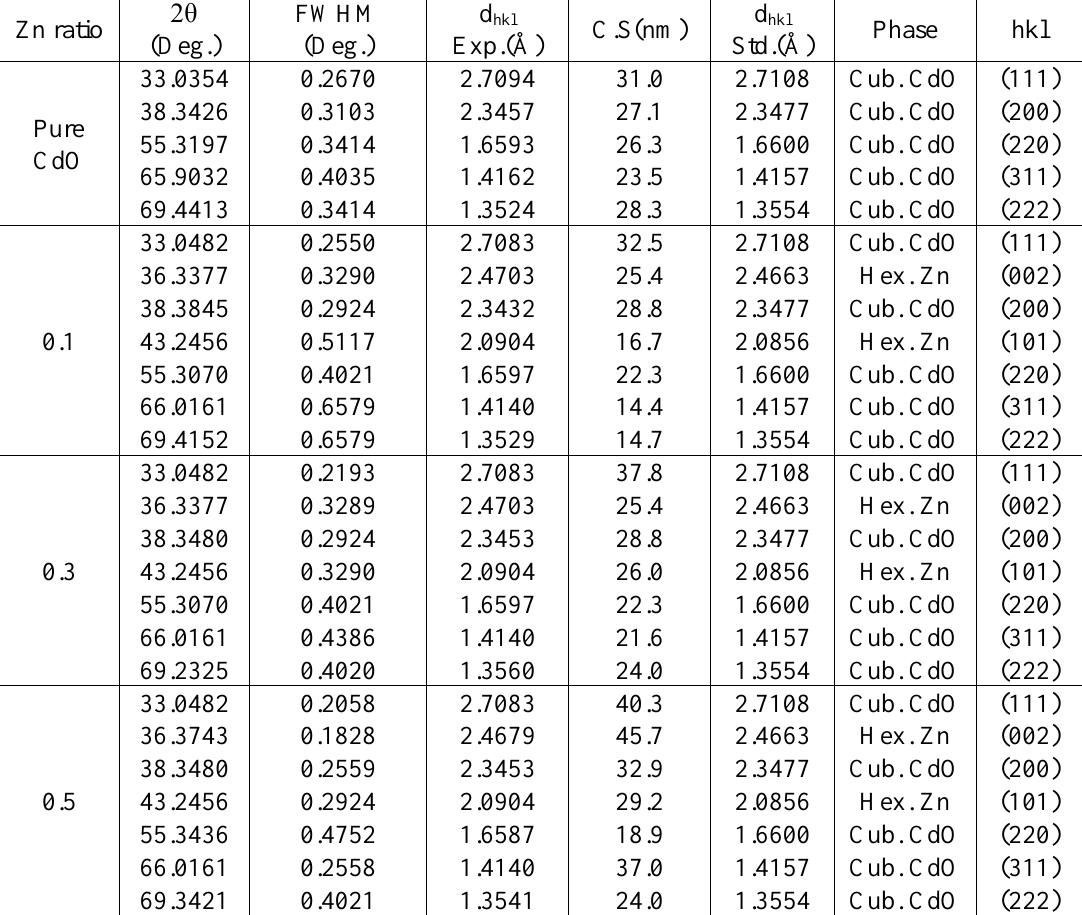
Zn thin film at different ratios. 1-x x